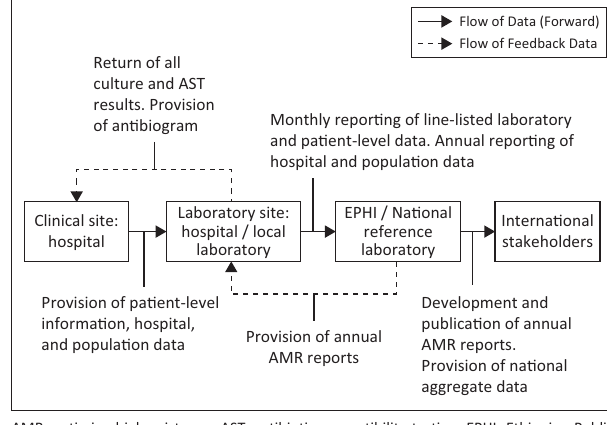
FIGURE 1: Diagram of AMR surveillance data flow within the Ethiopia National Antimicrobial Resistance Surveillance System.